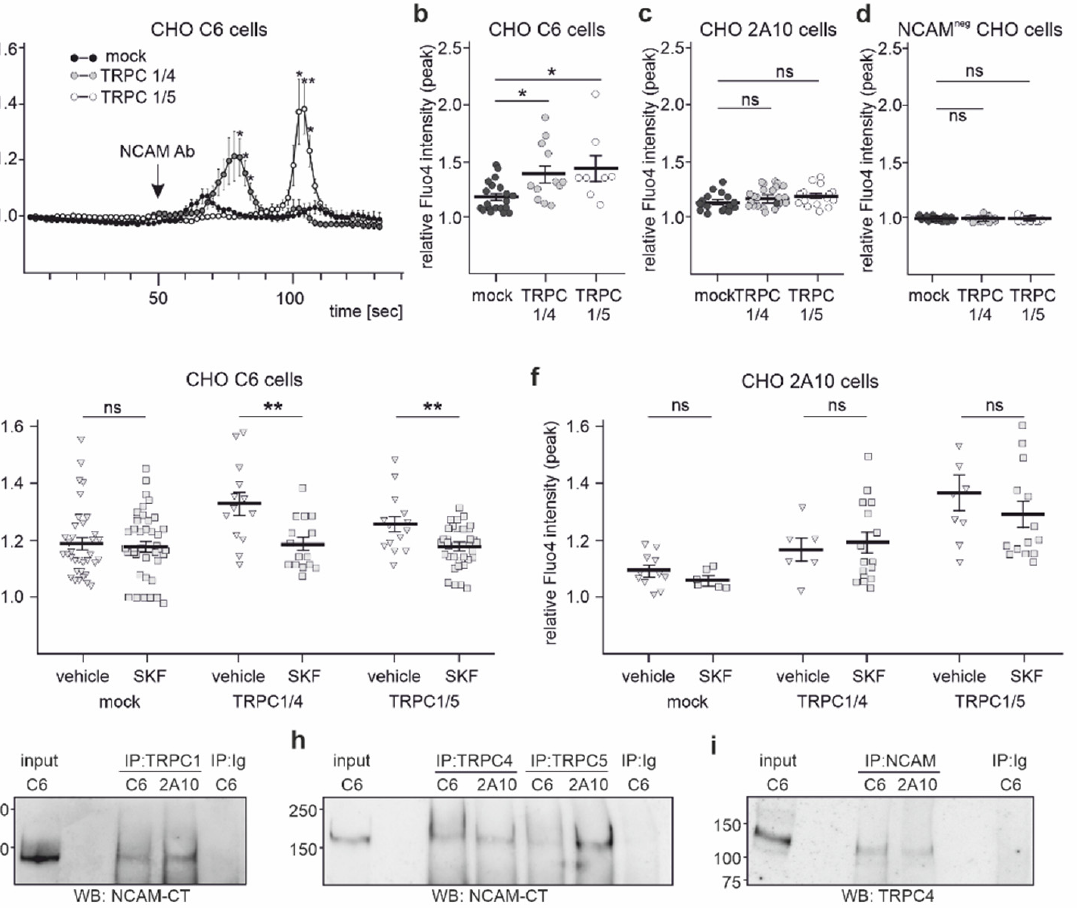
the ER membrane marker protein (green) (NCAM/TRPC1/ER) (scale bar: 20 µm). ( c ) Representative images are shown for interactions of TRPCs with NCAM or PSA at the cell surface (scale bar: 20 µm). The numbers of red dots near to the plasma membrane marker (blue) or to the ER marker (green) were counted separately (over- lapping dots were not considered) and indicate the interaction of NCAM or PSA with TRPCs in the plasma membrane or in ER membranes near the plasma membrane. ( d , e ) Scatter plots show mean values ± SEM and single values for the numbers of plasma membrane-associated (PM) and ER-associated (ER) red dots per cell from 3 independent experiments analyzing 10 neurons per group and experiment (*** p < 0.001; Mann–Whitney test comparing PM and ER values). 2.4. NCAM Regulates the Influx of Ca 2+ via TRPC1, − 4, and − 5 To investigate whether PSA and/or NCAM regulate Ca 2+ influx via TRPC1/4 and/or TRPC1/5 heteromers, CHO 2A10 cells expressing NCAM, but not PSA, and CHO C6 cells